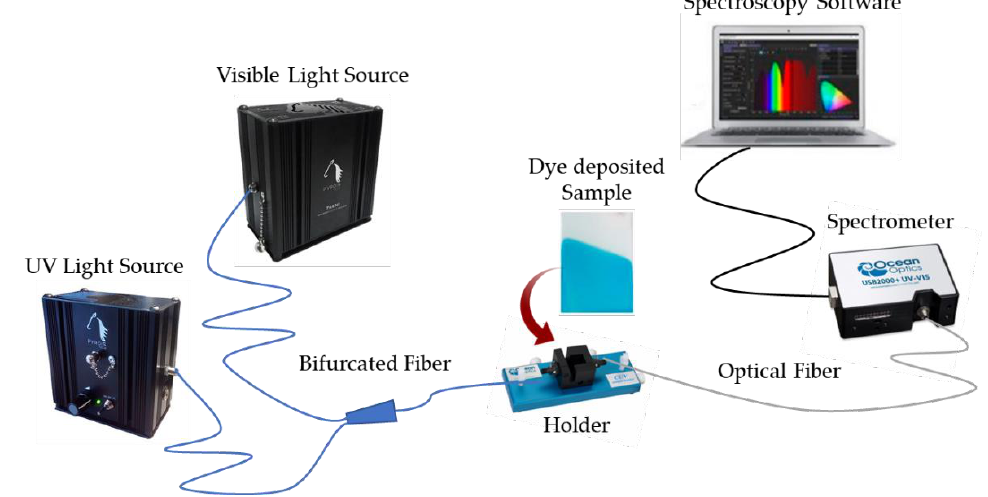
Figure 2. Scheme of the described setup for photocatalytic efficiency determination of the